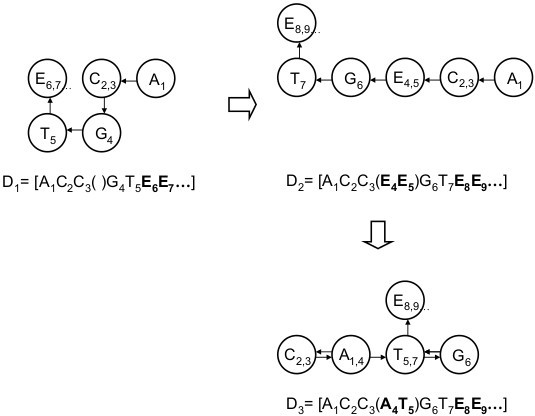
Graphical representations for changes of DNA sequences. Suppose next sequences; ‘D1 = [A1C2C3( )G4T5E6E7E8…]’, ‘D2 = [A1C2C3(E4E5)G6T7E8E9E10…]’ and ‘D3 = [A1C2C3(A4T5)G6T7E8E9E10…]’, a series of changes, ‘D1 → D2 → D3’ are drawn as three polygonal lines where each bases are linked also in the definition of group Z5. There, we recognize not the locations of ‘D’s but mere alphabets, indexed number and shapes.